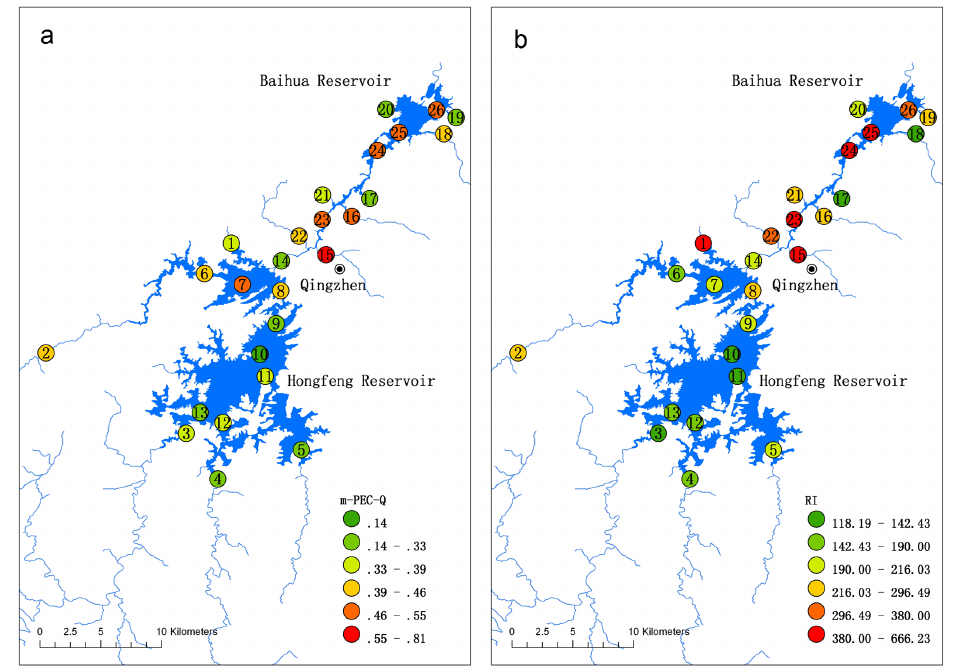
Figure 4. Mean PEC quotient (a) and potential ecological risk indexes (b) of heavy metals in sediments.